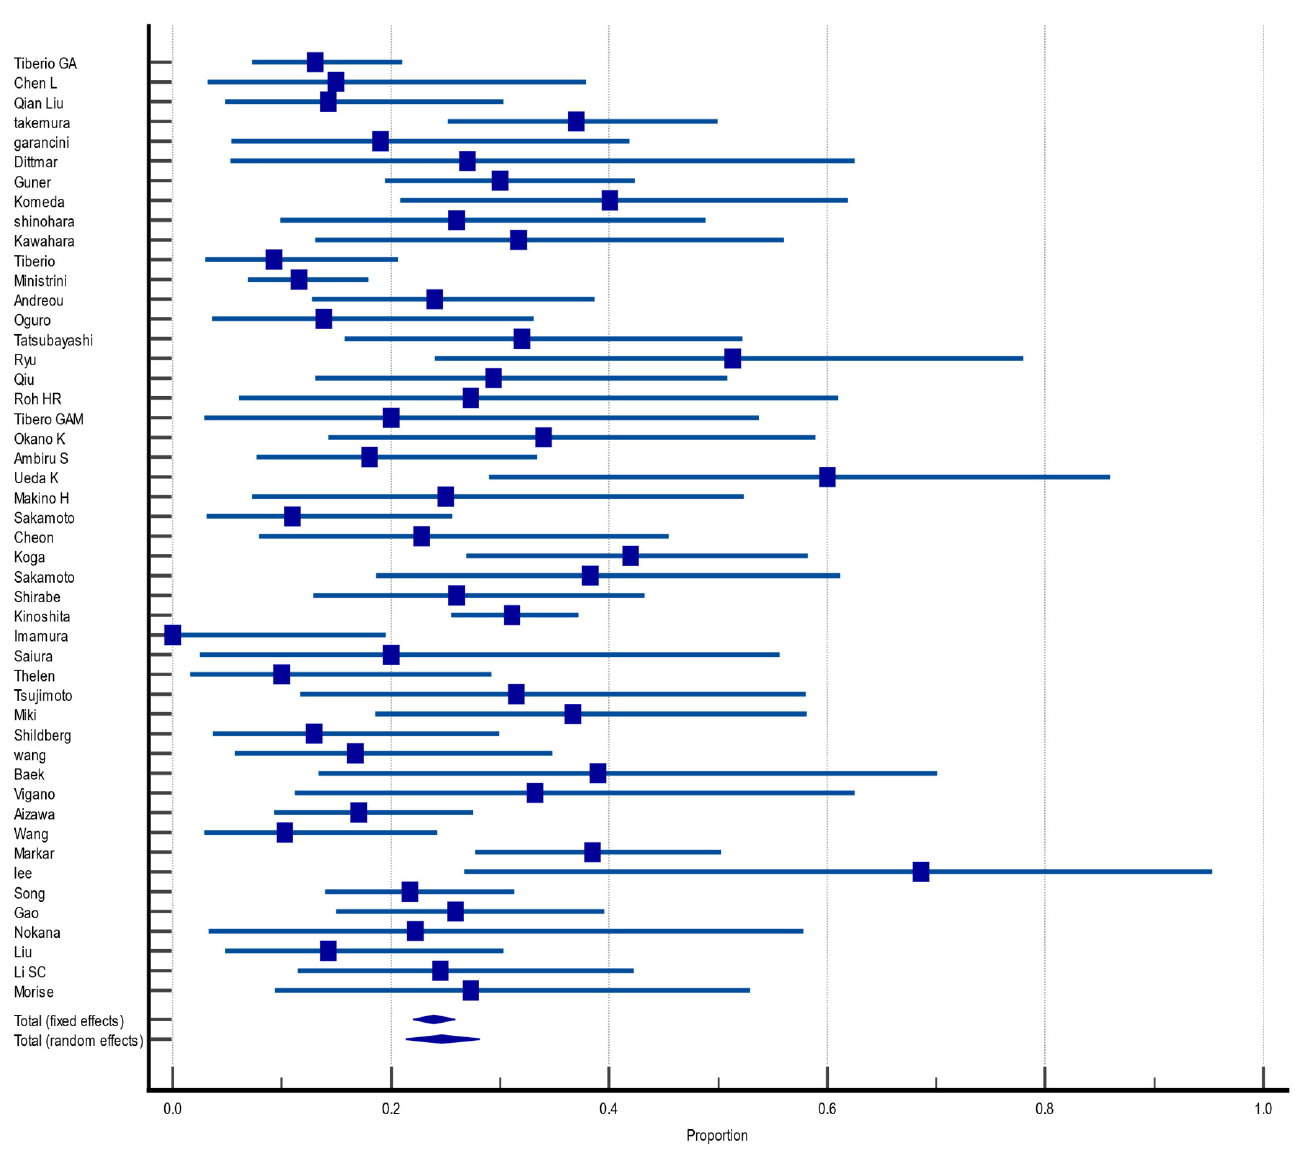
Figure 4. Forest plot of overall survival at 5 years after hepatectomy for gastric cancer liver metastasis (GCLM). Description of the proportion and confidence intervals at 95% in the studies that reported 5-year overall survival.